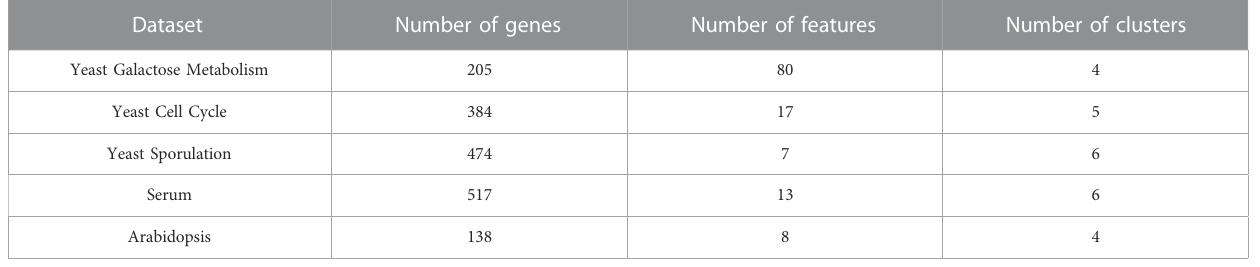
TABLE 1 Description of datasets.